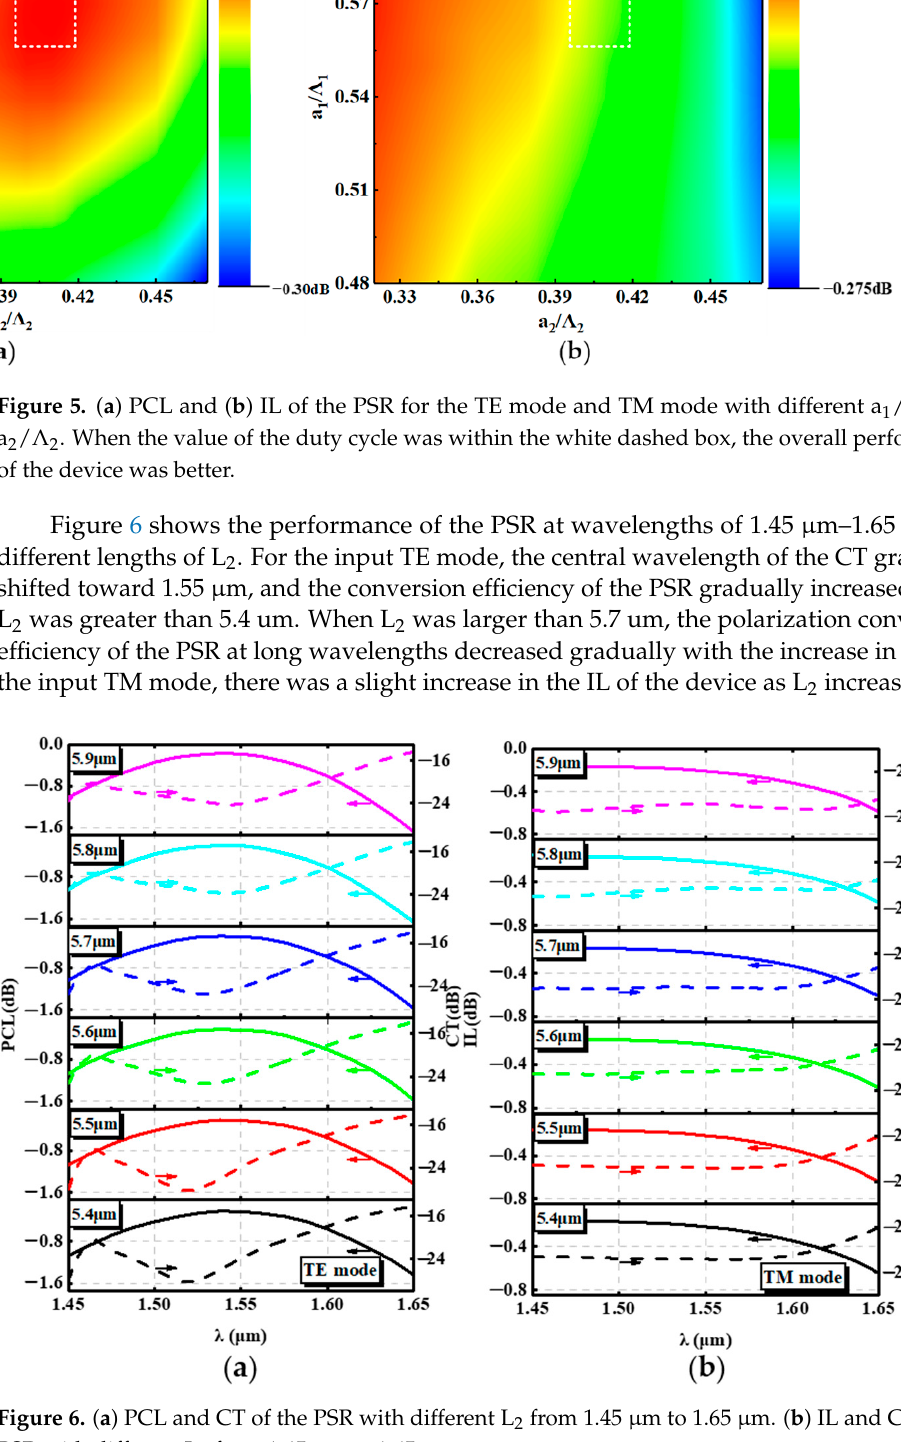
Figure 6. ( a ) PCL and CT of the PSR with different L 2 from 1.45 μ m to 1.65 μ m. ( b ) IL and CT of the PSR with different L 2 from 1.45 μ m to 1.65 μ m.